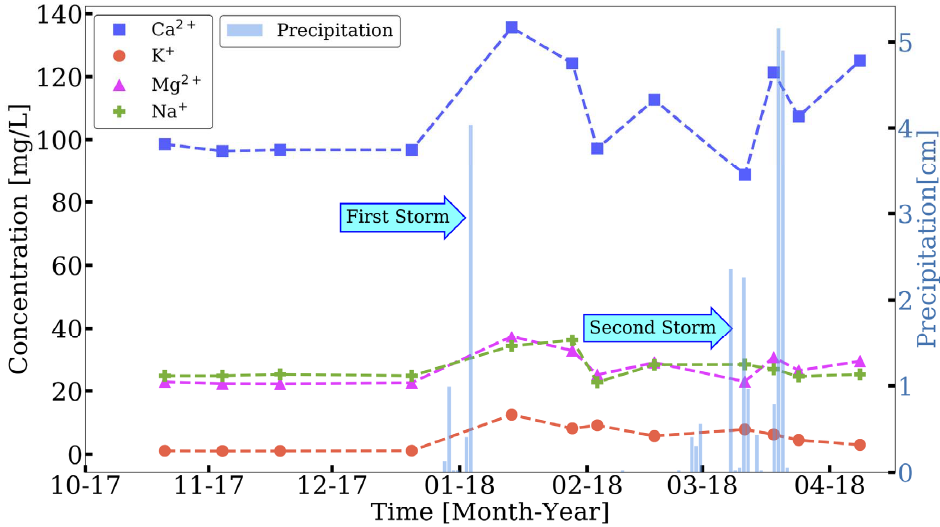
Figure 3. Major cation concentrations at Upper El Cap (East Fork) site and precipitation data. Precipitation data are expressed as cumulative precipitation each day. Precipitation events clustered into two major storms, referred to as the first major storm (inclusive of 6 January 2018) and the second major storm (inclusive of 10 March 2018) of the season